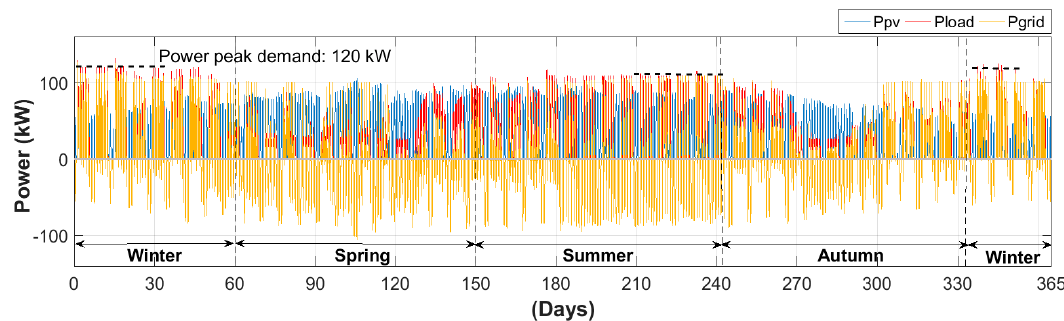
Figure 7. Electricity flows in office building with PV system during a year (Case 2).